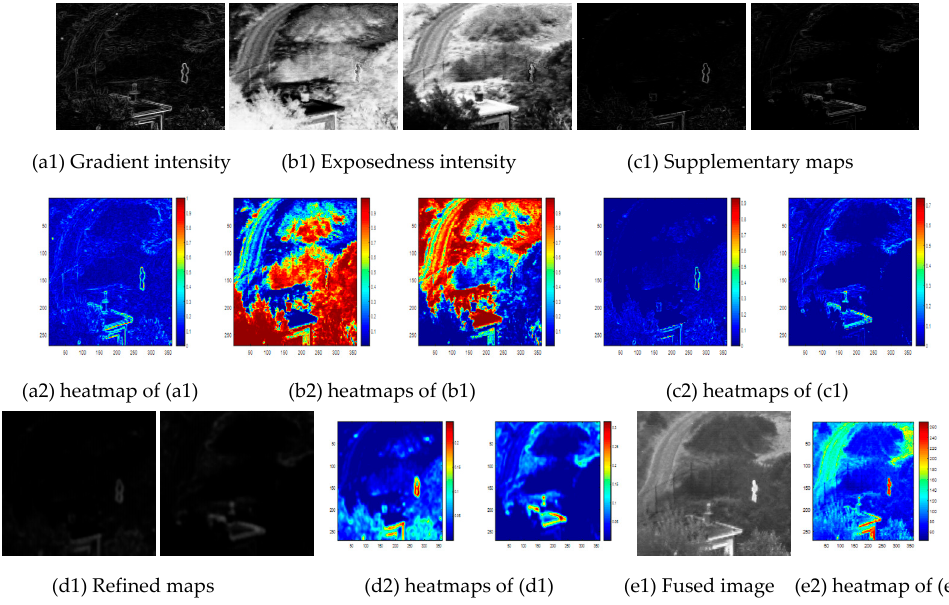
Figure 9. The visual maps and their corresponding heatmaps of IBSM in the fusion framework (Fig- ure 1).